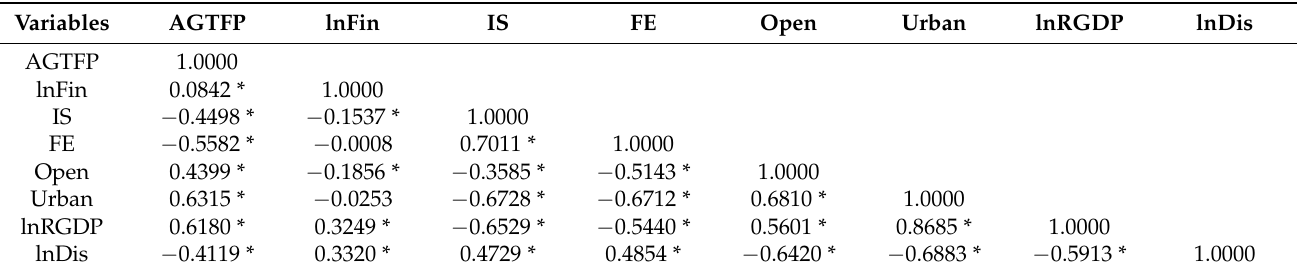
Table 5. Correlation matrix of